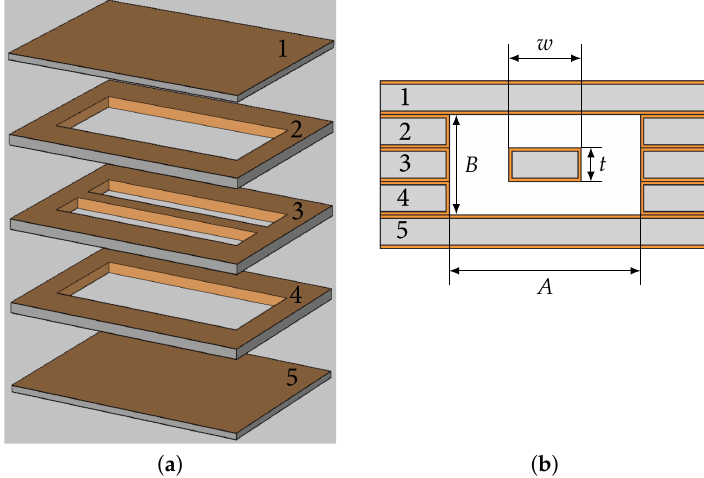
Figure 1. Simplest construction of an empty substrate integrated coaxial line (ESICL) (source Reference [27]). Layer 1 and 5 are top and bottom covers; layer 3 is the central layer with transitions to planar lines; layers 2 and 4 separate the central layer from the covers. ( a ) 3D view of layers before assembling; ( b ) Cross-section of the ESICL after